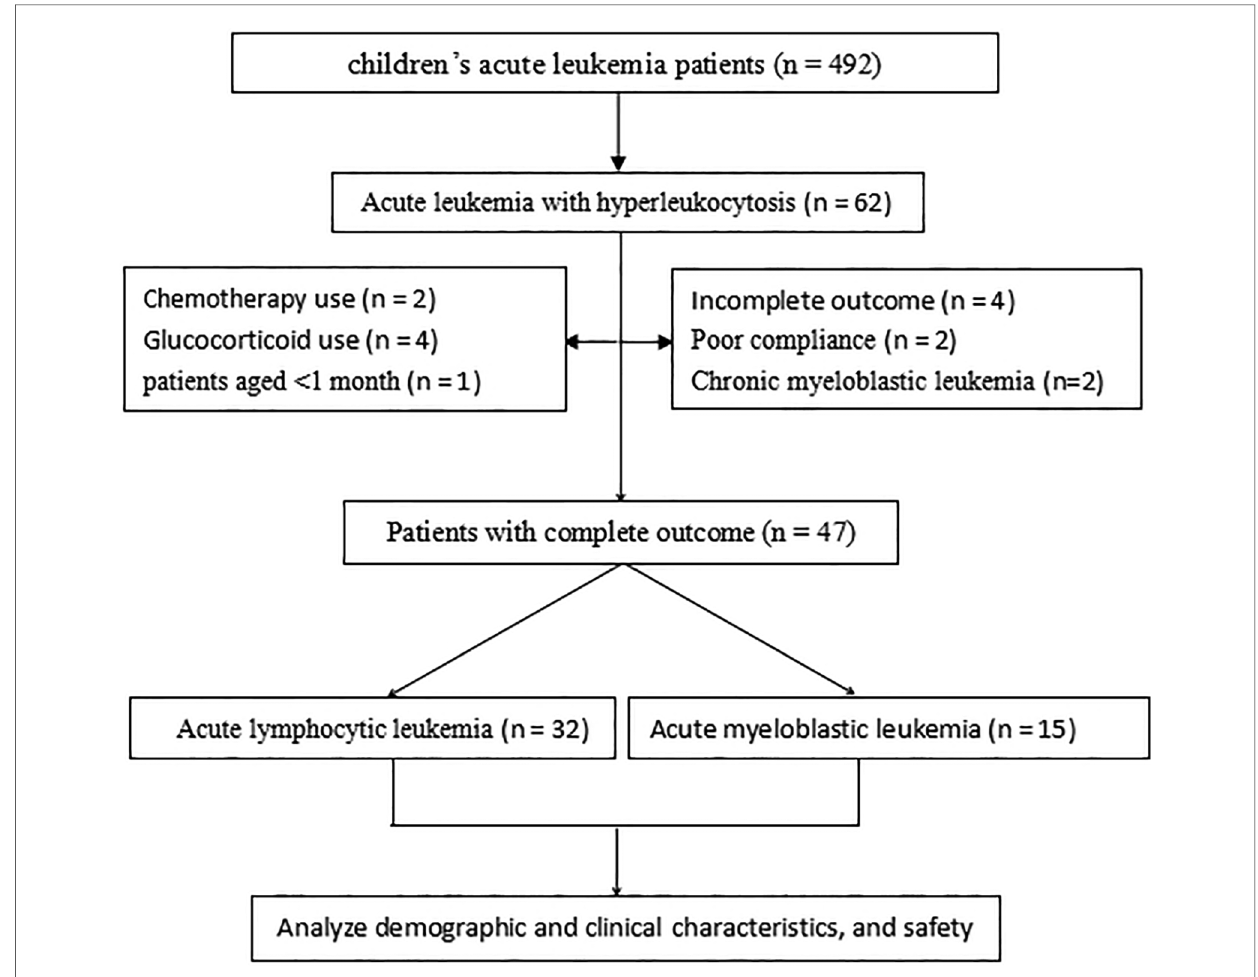
FIGURE 1 Flowchart of patients included in the